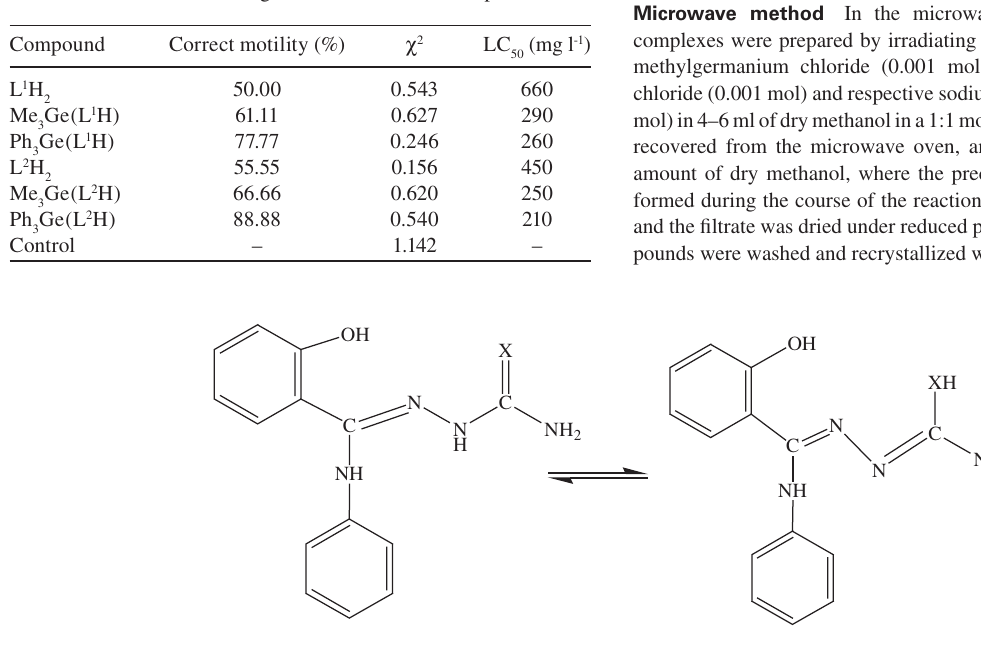
Figure 2 Equilibrium forms of the ligands . X = O for L 1 H /S for L 2 H 2 2